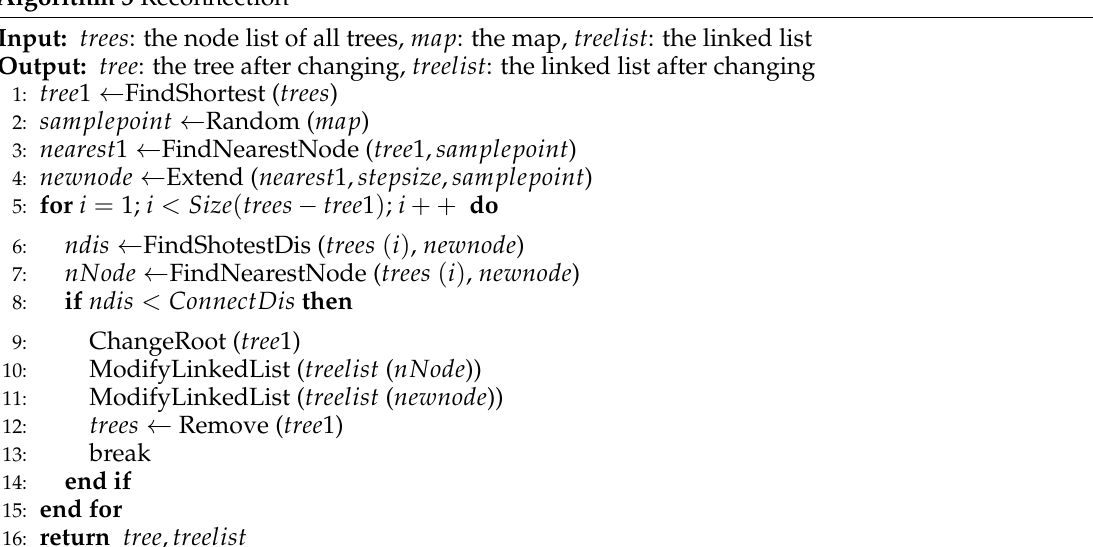
Algorithm 3 Reconnection